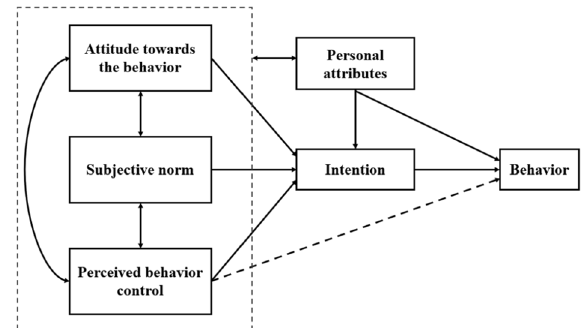
Figure 1. Theoretical framework of the extended theory of planned behavior. Note Attitude towards the behavior refers to people’s positive or negative feelings towards the behavior in question. Perceived behavioral control indicates people’s perception of ease or difficulty in performing certain behaviors. Subjective norms reflect the individual’s perception that people who is important to the individual should perform the behavior. Personal attributes cover gender, major, grade and financial condition.